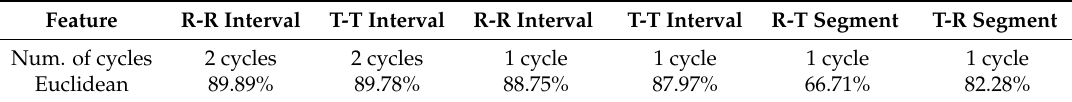
Table 4. Identification rates with different segments using wrist ECG data for 55 subjects. Feature R-R Interval T-T Interval R-R Interval T-T Interval R-T